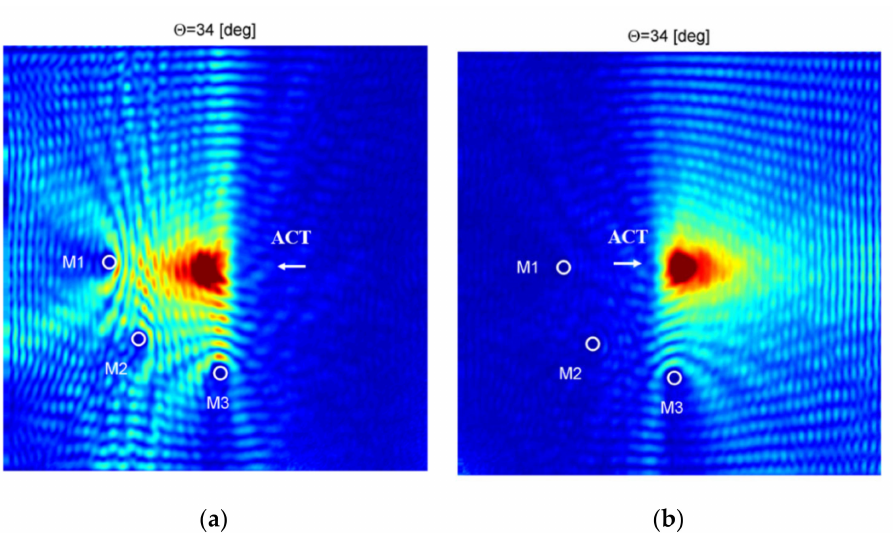
Figure 17. RMS energy map for the plate with discontinuities; ACT oriented at θ = 34 ◦ (across reinforcing fibers) and directed to: ( a ) left part of plate, ( b ) right part of